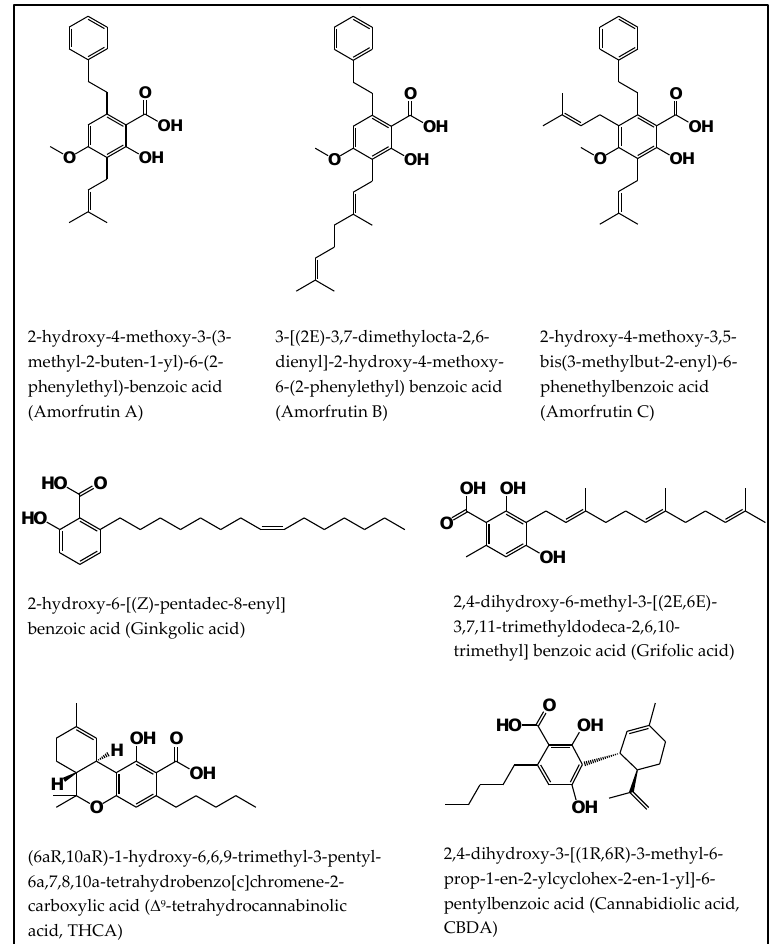
Figure 1. Chemical structures of our focused natural salicylates. Distinct phenyl moieties are contained in amorfrutins (A, B and C), THCA and CBDA, whereas fatty acids-based residues are contained in amorfrutins (A, B and C), gingkolic acid, grifolic acids, THCA and CBDA.